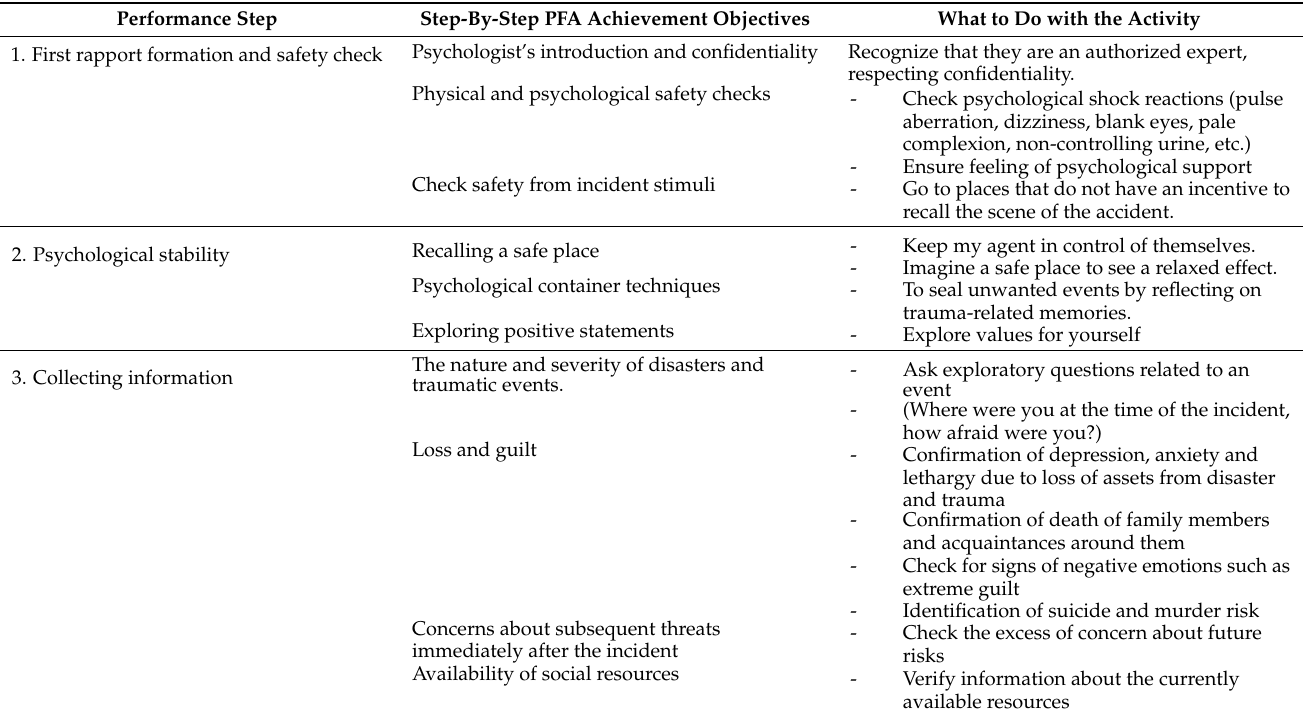
Figure 2. PFA guidelines development process. Table 2. Psychological first-aid guidelines: a conceptual